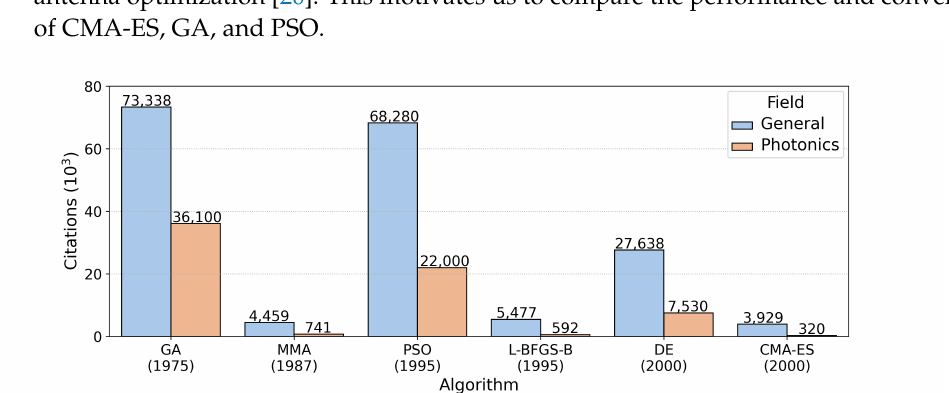
Figure 1. Timeline of the optimization methods. Adoption by the number of citations in pho- tonics compared to the total citations (based on Google Scholar results). GA: genetic algorithms; MMA: moving asymptotes; PSO: particle swarm optimization; L-BFGS-B: limited memory Broy- den–Fletcher–Goldfarb–Shanno bound constrained; DE: differential evolution; CMA-ES: